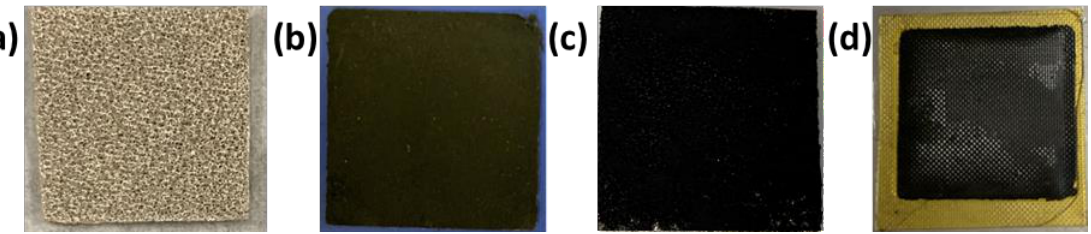
Figure 1. ( a ) Nickel foam ( b ) carbon paper coated with Pt/C catalyst, ( c ) Nickel foam anode coated with NiFeCoO x catalyst and ( d ) AEM with carbon paper cathode attached on one side. The dimen- sions of the electrodes were 1.8 cm × 1.8 cm.